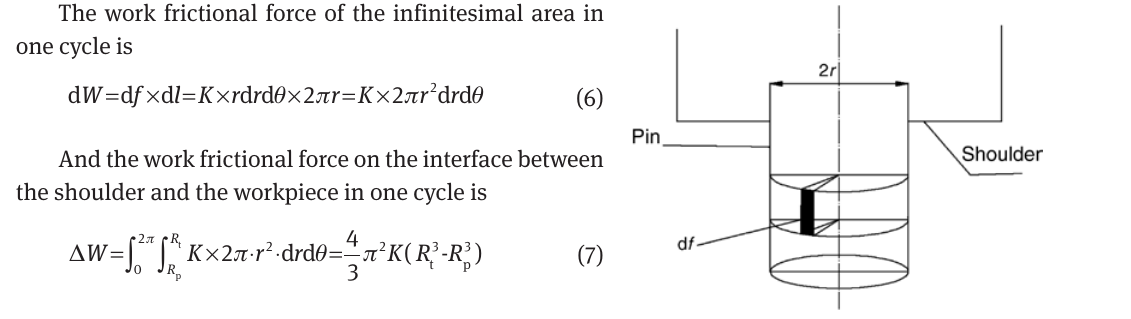
Figure 5: The multiplication model on the cylindrical area of the pin.